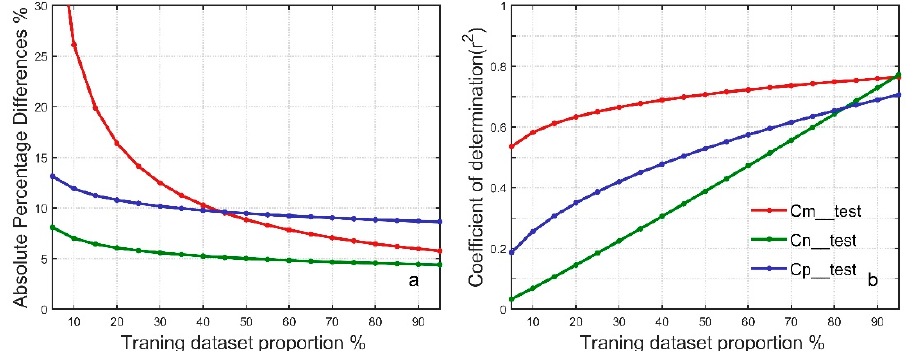
Figure 5. Cross-validation of splitting the data into training and testing datasets. ( a ) Absolute percentage differences (in %) of model derived for PSCs with respect to ratio of training dataset. ( b ) Coefficient of determination of the derived PSCs with respect to ratio of training dataset. The broken lines indicate the test dataset. Red, green, and blue represent Cm, Cn, and Cp, respectively.